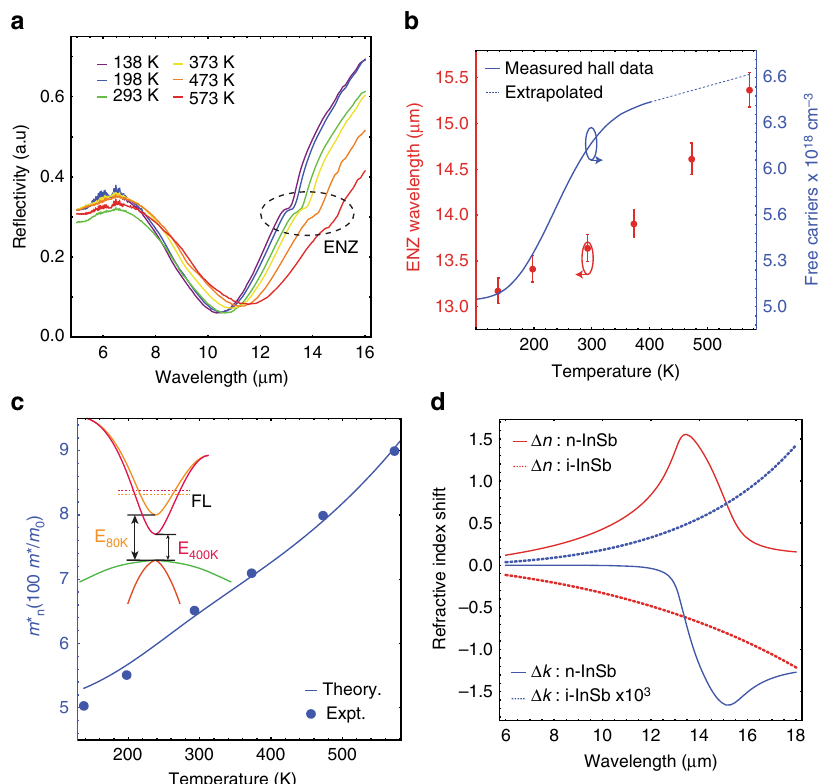
Fig. 2 Refractive index modulation of doped InSb. a Re fl ection spectra of a highly doped InSb fi lm at various temperatures. The dashed ellipse highlights a feature on the curve that marks the epsilon-near-zero ( ENZ ) wavelength. The ENZ wavelength red shifts with increasing temperature. b Plot showing the thermal dispersion of λ ENZ ( red dots , left axis ) and free-carrier concentration ( blue curve , right axis ). λ ENZ is determined from transfer-matrix modeling of plots in Fig. 2a and the error bars represent possible variation in the measurements due to the detector resolution limit. Free-carrier concentration is determined from Hall measurements. c Plot showing the experimentally determined optical effective mass ( m optical , blue dots ) as a function of temperature. The effective mass increases by ~80%. The blue curve ( left axis ) indicates the predicted thermal dispersion of the electron effective mass for n-InSb according to Eqs. 4, 5. (inset) As temperature increases, changing band curvature and a shrinking bandgap leads to effective mass variation at the Fermi-level ( dashed lines ) for highly doped InSb d Plot showing the fi tted refractive index change for both doped InSb (real part: red solid line ; imaginary part: blue solid line ) between 573 K and 138 K and intrinsic InSb (real part: red dashed line ; imaginary part: blue dashed line ) from 295 K to 525 K. Note that the real part (imaginary part) increases (decreases) when doped InSb is heated, while the opposite is true for intrinsic